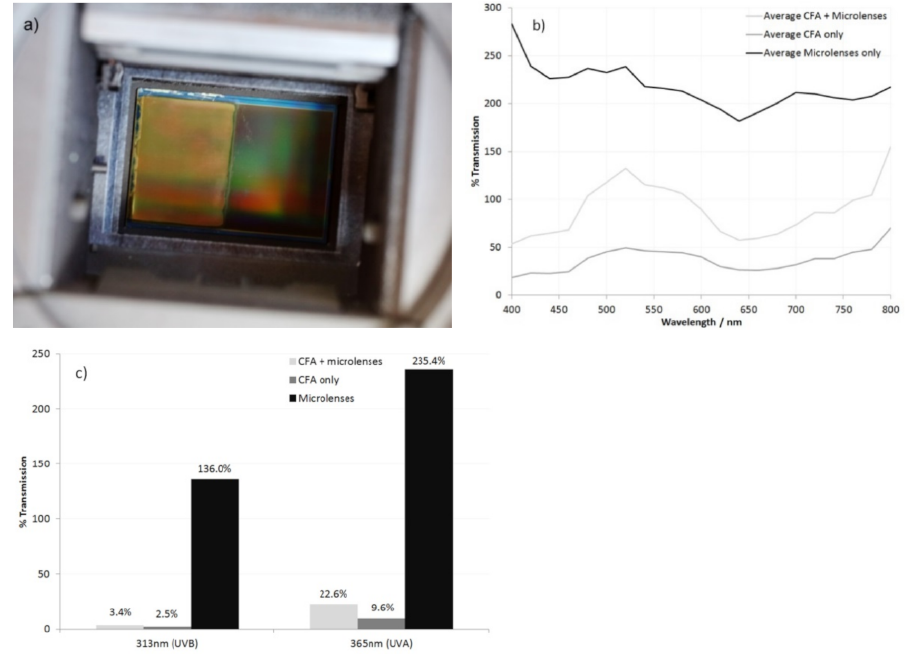
Figure 7. Sensor with half the CFA/microlens array removed; ( a ) appearance of the sensor; and per- centage transmission between for the CFA+ microlenses, CFA only, and microlenses only, calculated from the average channel response; ( b ) 400 and 800 nm ( c ) at 313 and 365